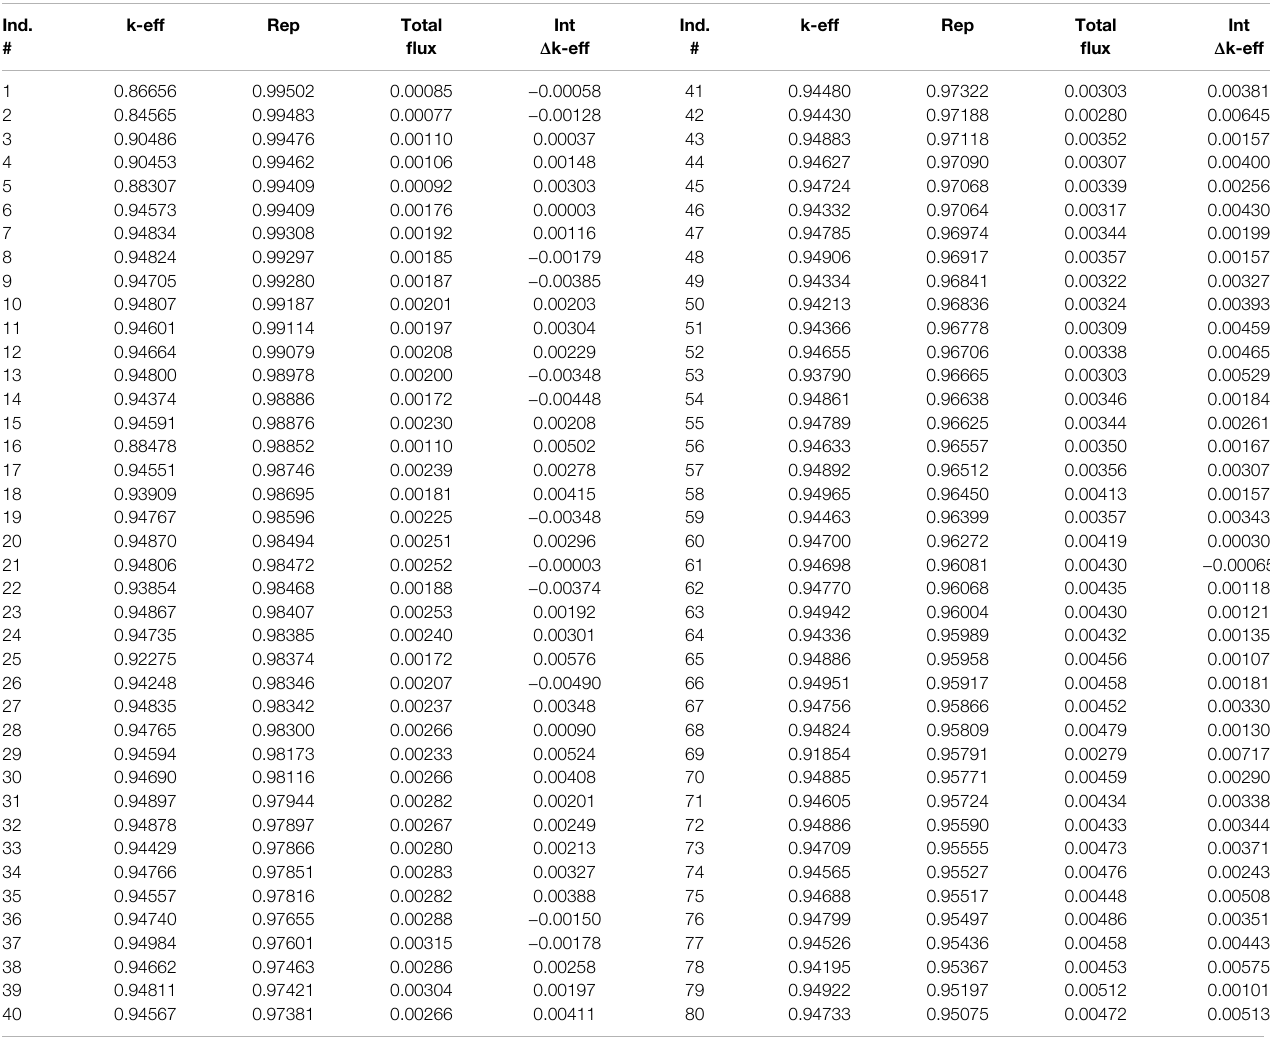
TABLE 4 | Final 100 individuals CNN-surrogate NSGA-II